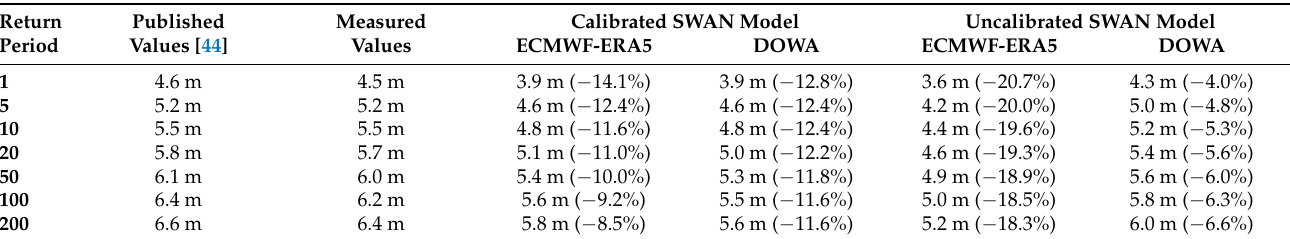
Table 9. Calculated EVA values (and percentage difference between the measured and modelled values) from measurements and SWAN models, computed on the fine grid (2.5 km), compared to published values for deep water station at Westhinder.